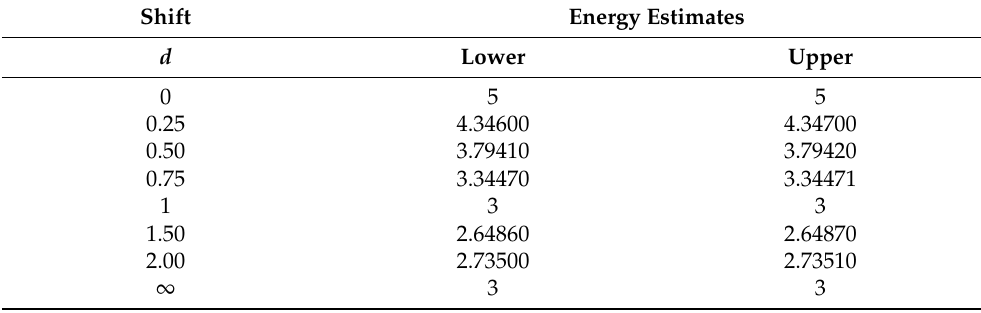
Table 5. Shift-dependence of the 2nd-excited-state energy (at d = 1 the state is quasi-exact). Shift Energy Estimates d Lower Upper